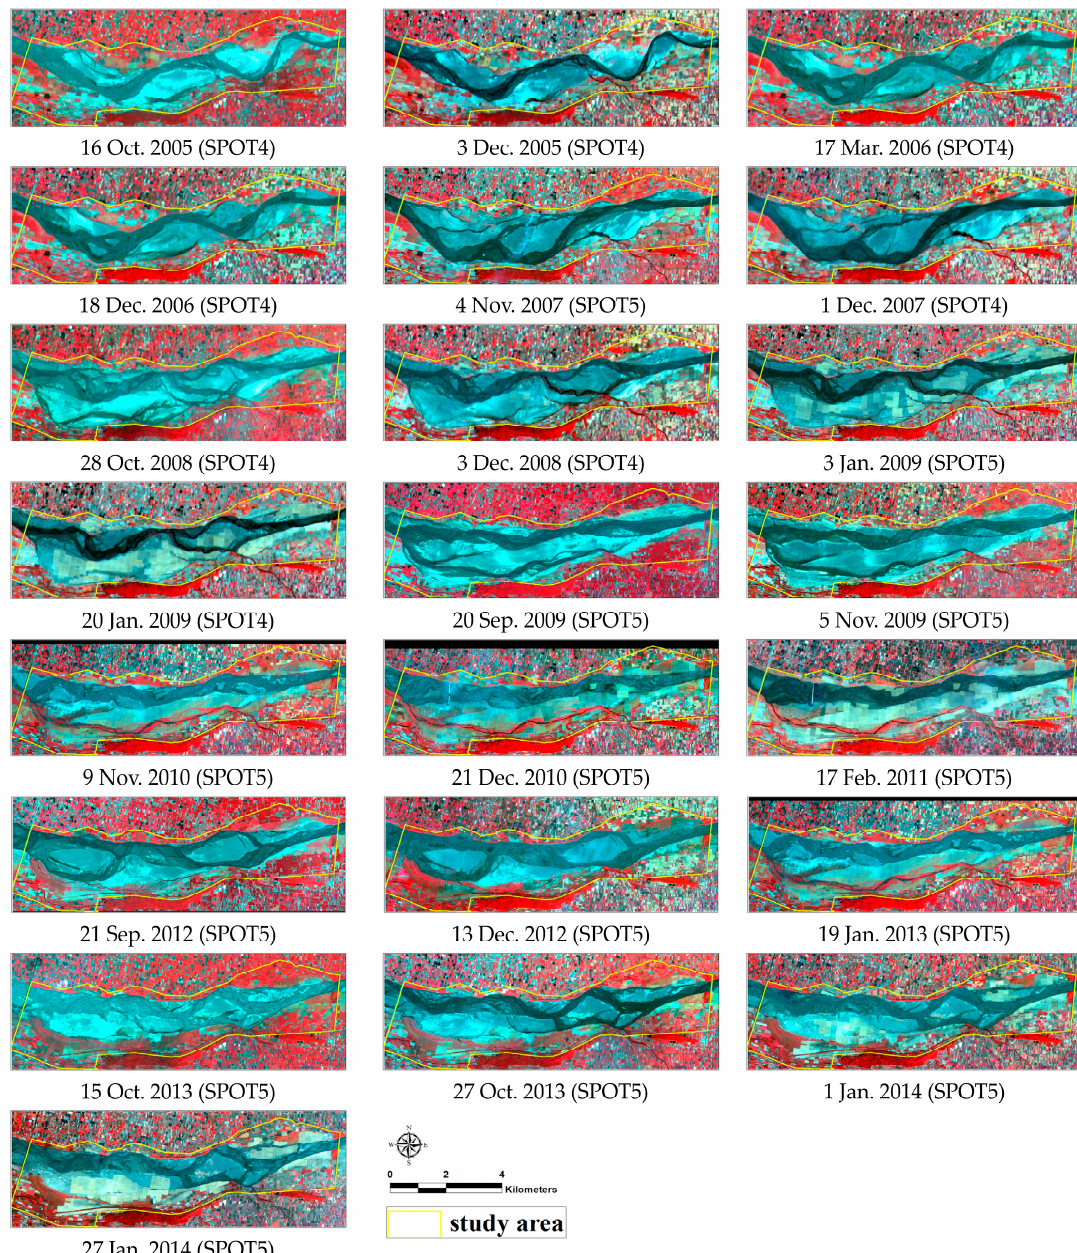
Figure 3. Satellite images used in this study.